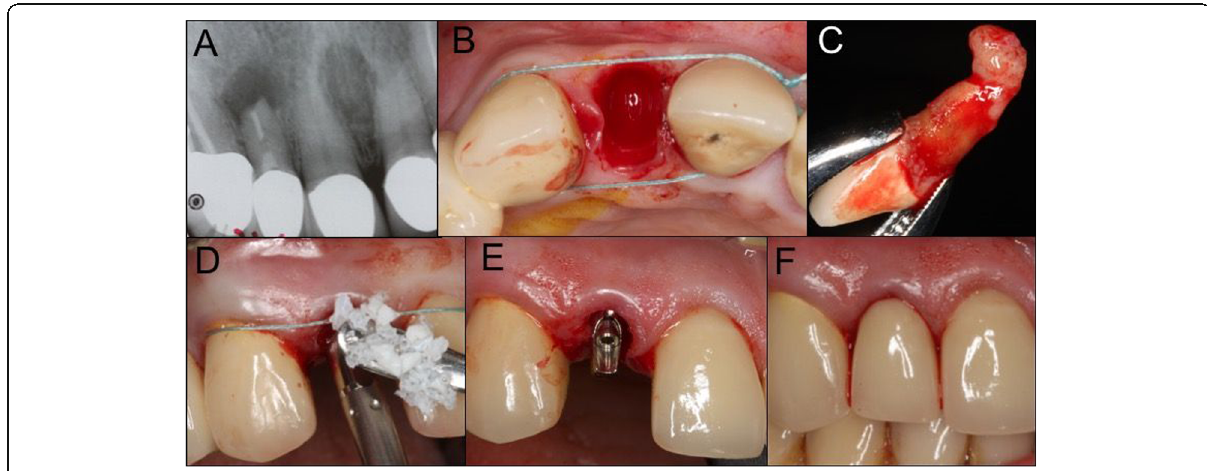
Fig. 1 Surgical and prosthetic protocol. a Initial periapical radiograph showing periapical lesion tooth 12. b Intact post-extraction socket. c Extracted lateral incisor exhibiting an enucleated periapical cyst. d Fill of the gap between the implant and facial bone wall with xenogenic bone substitute. e Abutment placement. f Insertion of immediate